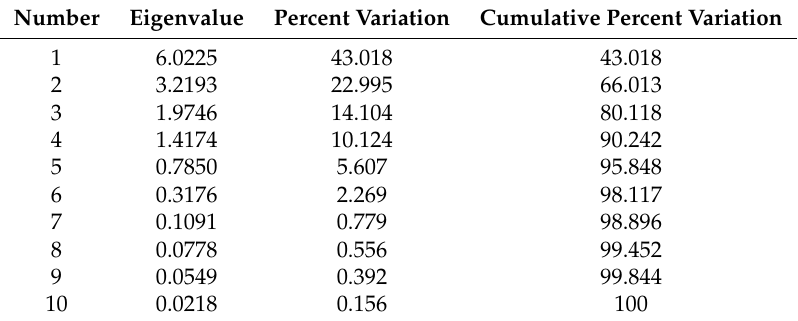
Table 4. Eigenvalues of the Normalized Input Variables Matrix Sorted in Descending Order (Based on Their Contribution to Total